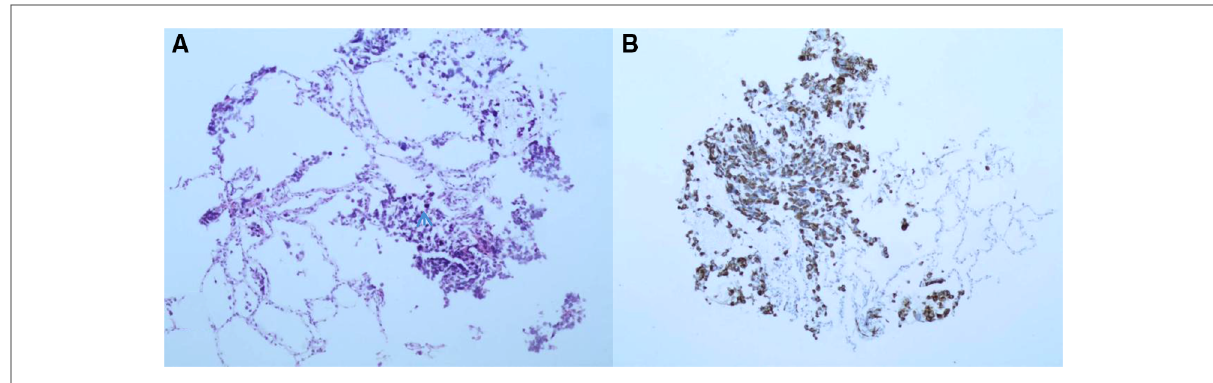
FIGURE 2 Histopathological examination of biopsy specimens in patient 2 showing rhabdomyosarcoma lung metastasis. ( A ) hematoxylin and eosin staining, ×100; ( B ) immunohistochemistry staining,